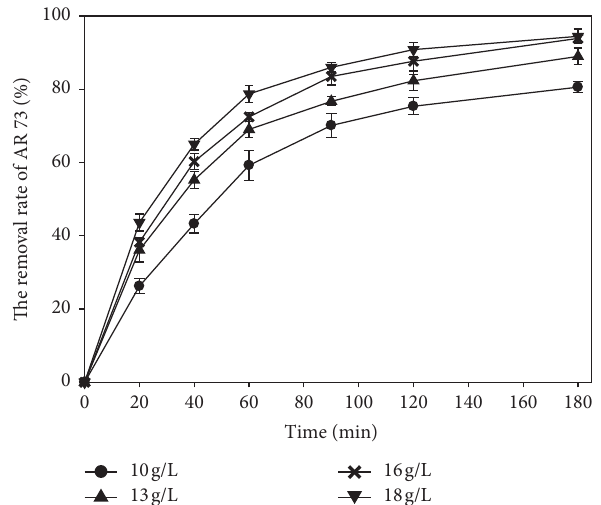
Figure 4: Effect of dosage of rice wine lees on removal of acid red